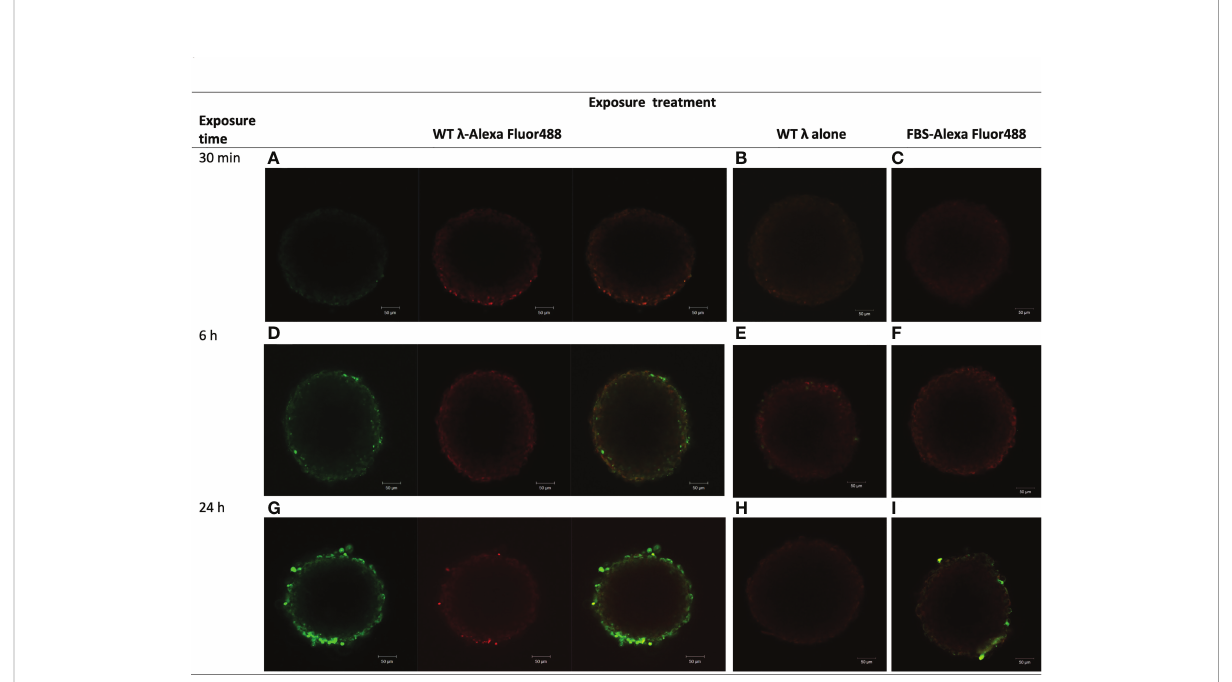
FIGURE 1 l phages adhere to and accumulate in NIH3T3 fi broblast spheroids. NIH3T3 spheroids (d7, 250 – 350 m m in diameter) were exposed to either WT l phages tagged with Alexa Fluor488 (A, D, G) , untagged l phages (B, E, H) , or FBS tagged with Alexa Fluor488 (C, F, I) for the times